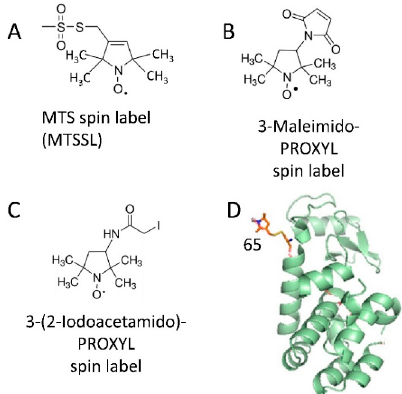
Figure 1. Spin labeling of proteins. ( A – C ) show nitroxide spin labels widely used for study of proteins by EPR spectroscopy. ( D ) emphasizes the residue 65 in T4 lysozyme spin-labeled with MTSSL. (PDB accession code 3LZM). Spin-label side chains were generated using the MMM program (Jeschke and Polyhach)